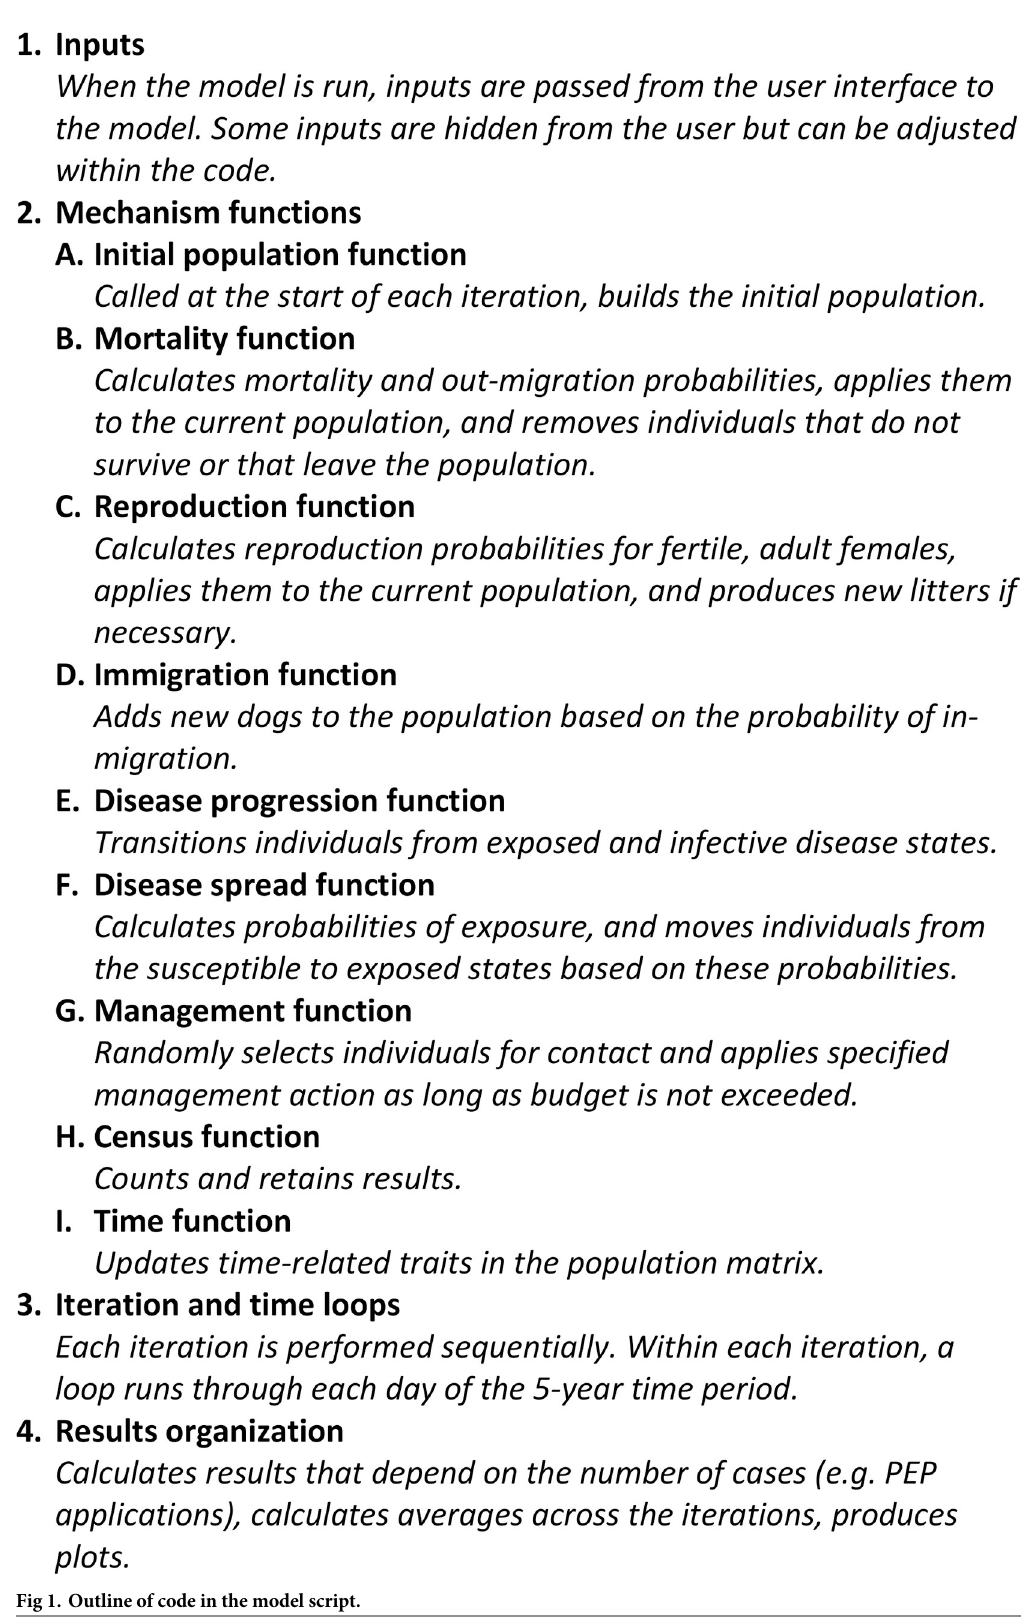
Fig 1. Outline of code in the model